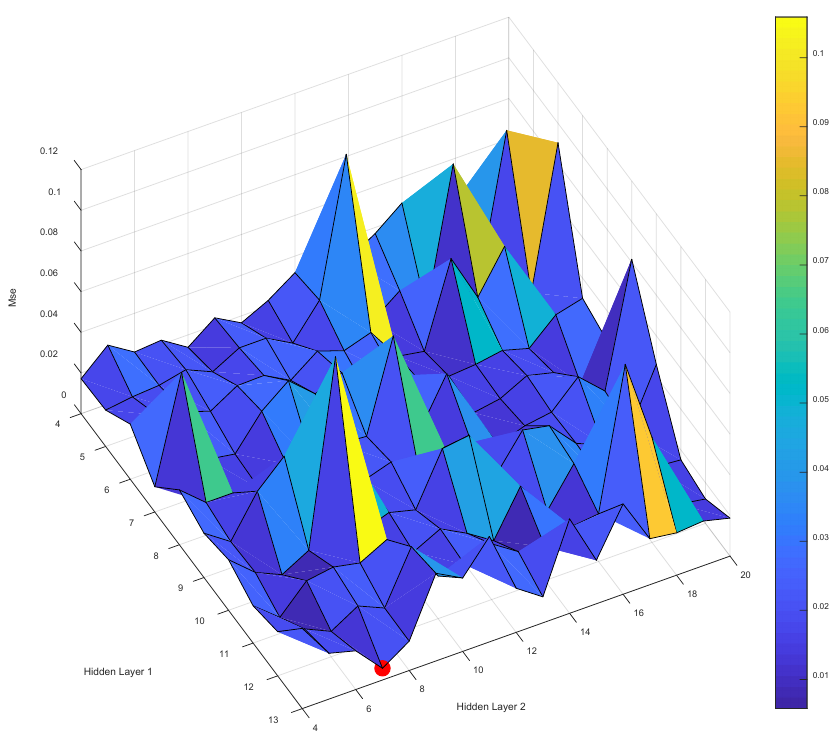
Figure 4. The effect of the hidden layer nodes on the training error of LM-ANN. The number of neuron nodes in the first hidden layer and second hidden layer were used as the X and Y axes, respectively. The evaluation index MSE was used as the Z axis. When the established model has the smallest MSE, the best performance of the established model is achieved. After we built 170 models, we obtained the minimum MSE value of 0.0057733 when the number of nodes in the first hidden layer was 13 and the number of nodes in the second hidden layer was seven. Table 5 lists the technical specifications of the LM-ANN. Table 5. LM-ANN’s technical parameters.